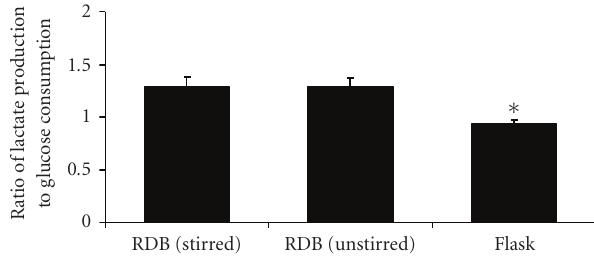
Figure 8: Lactate production in bioreactor cultures. Graph of lactate production by EL-4 colonies after culture in rotating disc bioreac- tors with stirring (Re = 600) or without stirring, compared to values of static flask cultures. Bars represent the means of 3 experimental groups; error bars represent standard error of the mean; the asterisk pertains to P < .